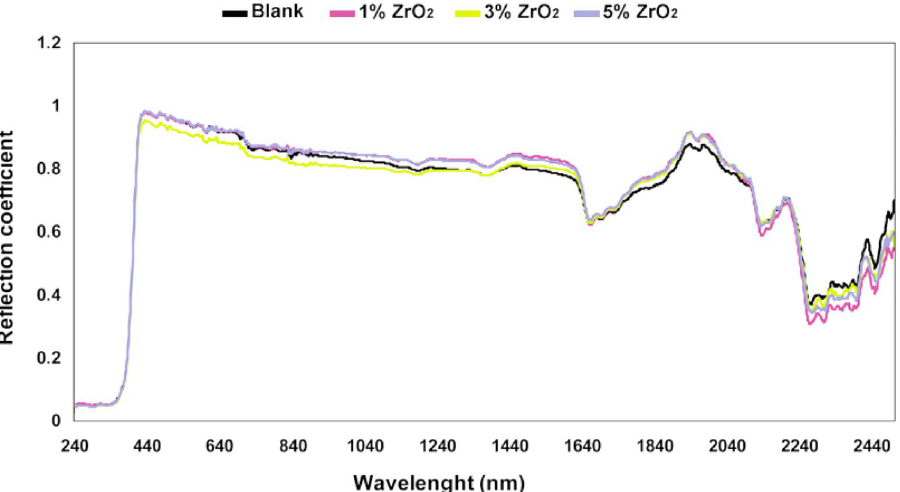
Figure 3. Absolute reflection coefficient of samples of nanocomposite coating for 0, 1, 3 and 5% of zirconium oxide nanoparticles in UV/VIS/NIR region.